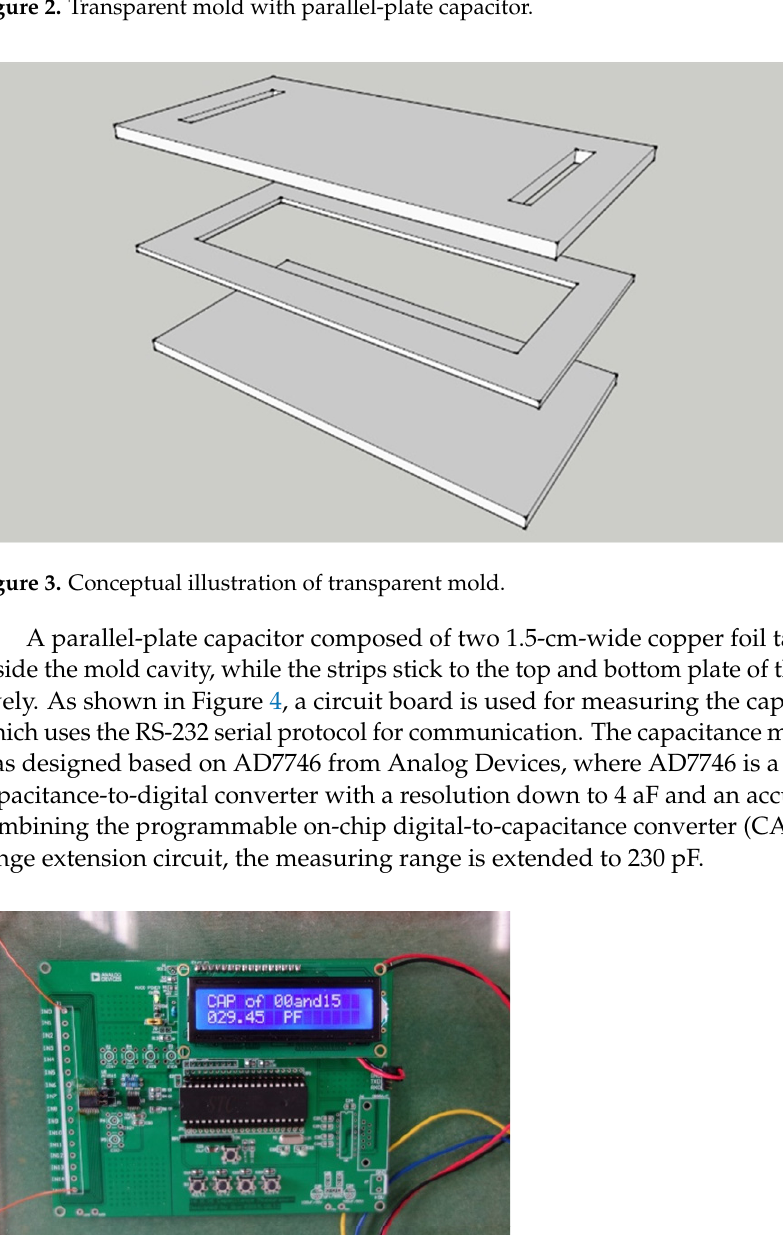
Figure 2. Transparent mold with parallel-plate capacitor.